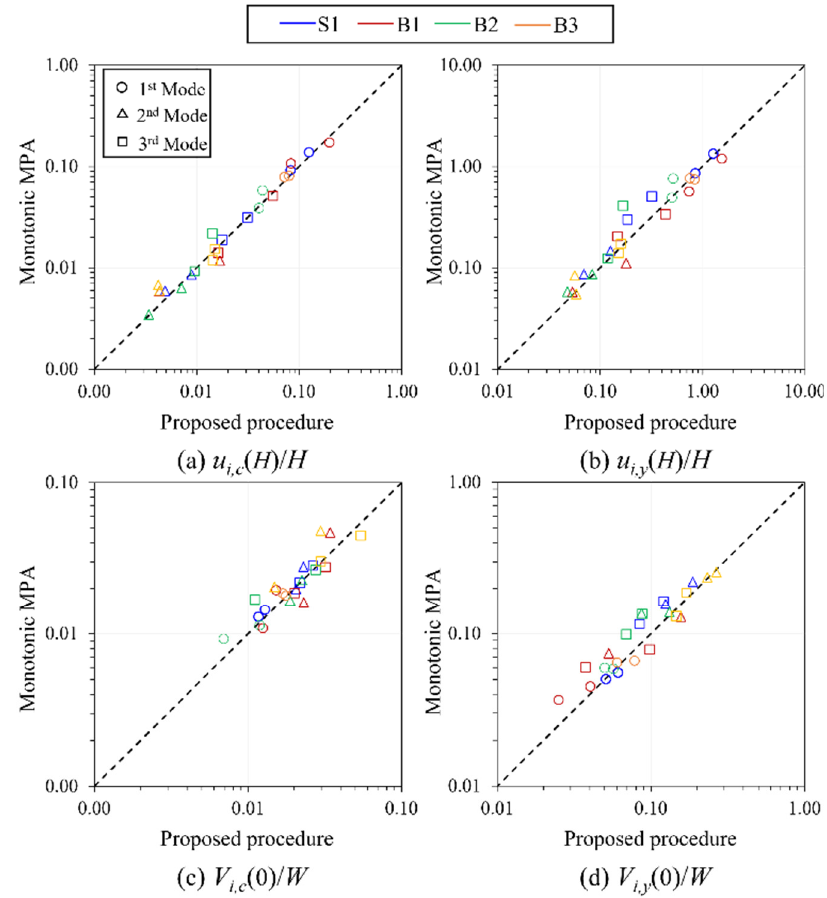
Figure 13. Coordinates at points A and B of the capacity curve.